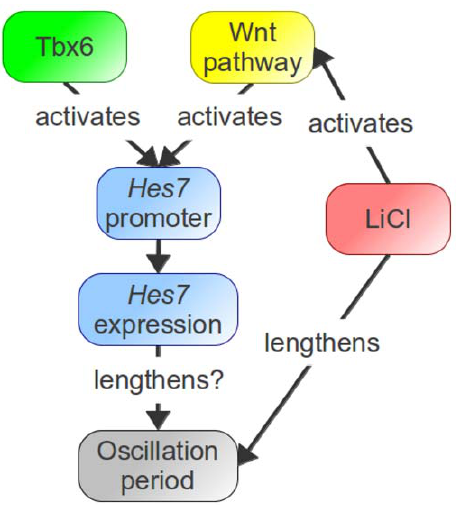
Figure 5. Role of Tbx6 and Wnt pathway on Hes7 regulation. Tbx6 binding sites and the Wnt pathway are required for normal Hes7 expression in the PSM. Furthermore, the Gsk3 inhibitor LiCl activates the Wnt pathway and lengthens the oscillatory period of Hes7 promoter activity.